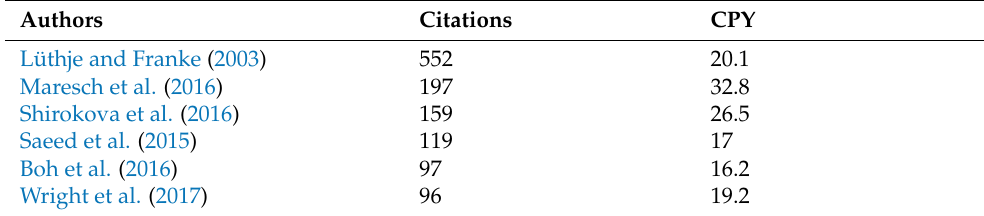
Table 4. Analyzed articles per citations and citations per